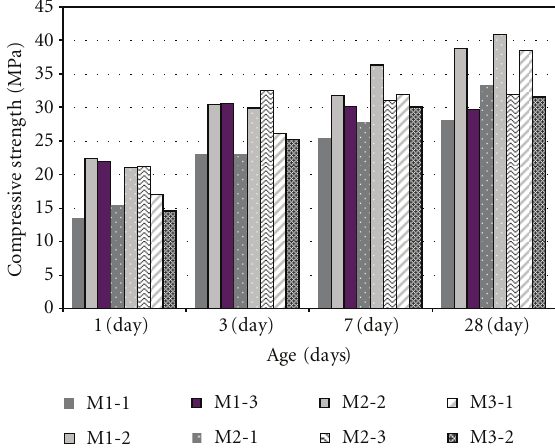
Figure 11: Compressive strength of all